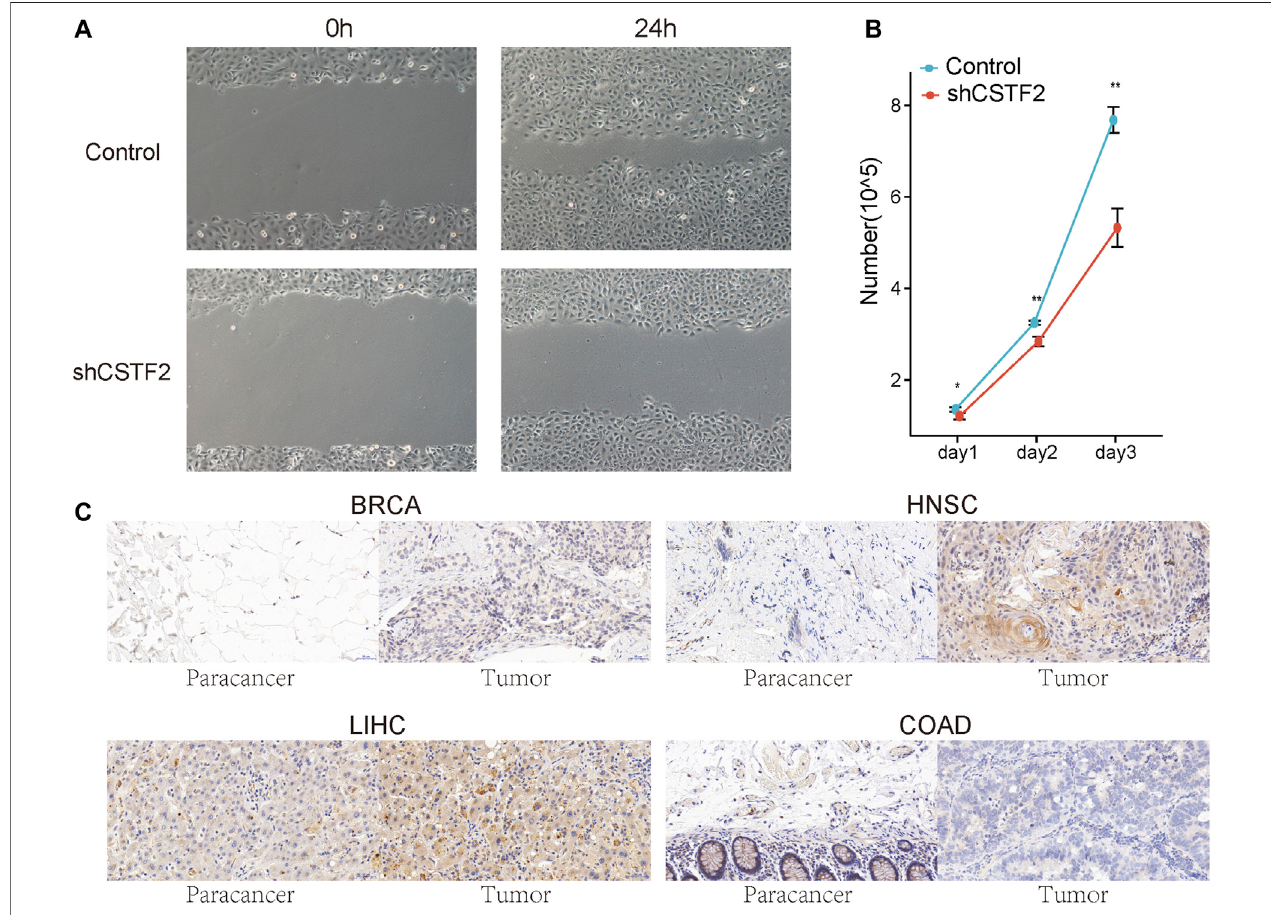
FIGURE 8| The effect ofCSTF2on tumors. (A) The migration of HN6 cells transfected with plko.1/plko.1-shCSTF2 wasobserved by scratch assay after 24 h. (B) The proliferation of HN6 cells with plko.1/plko.1-shCSTF2 was recorded at days 1, 2, and 3. All the experiments were veri fi ed by three independent repeated experiments. (C) Typical results of normal and tumor tissues in 1 BRCA patient, 5 HNSC patients, 1 LIHC patient, and 2 COAD patients.